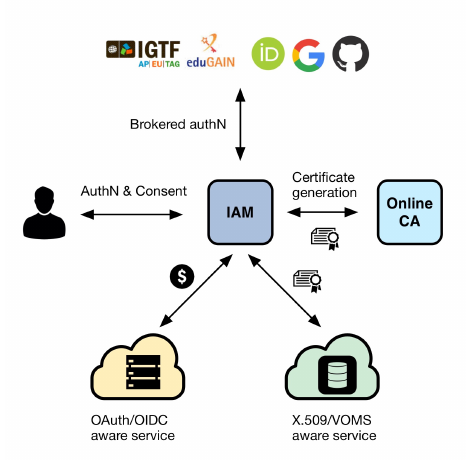
Figure 1. IAM enables a modern AAI for WLCG, with a transition path from X.509